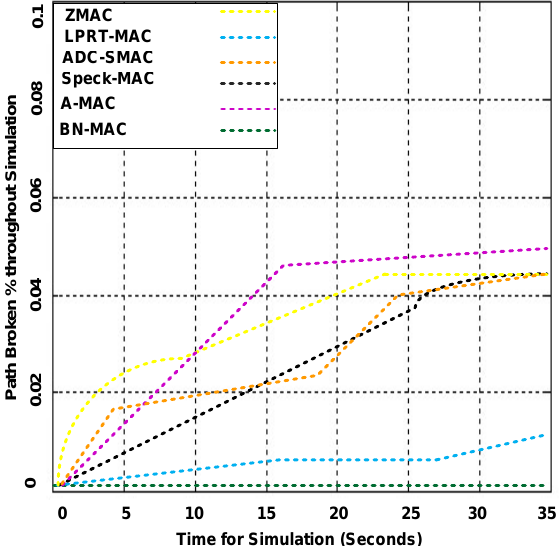
Figure 25. Broken paths% at different